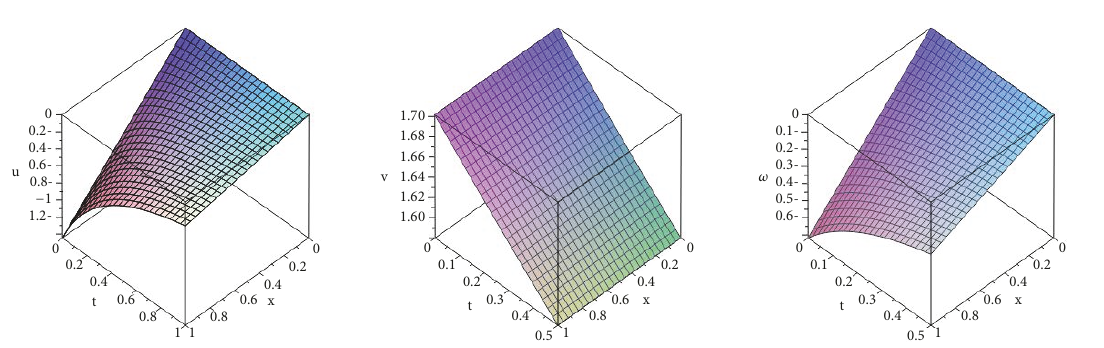
Figure 19: Surface of 𝑢 , V , and 𝜔 for 𝑀 = 2 , 𝑆 = −10 , 𝛾 = 0.3 , 𝑦 = 1 , 𝛼 = −2 , l = 3